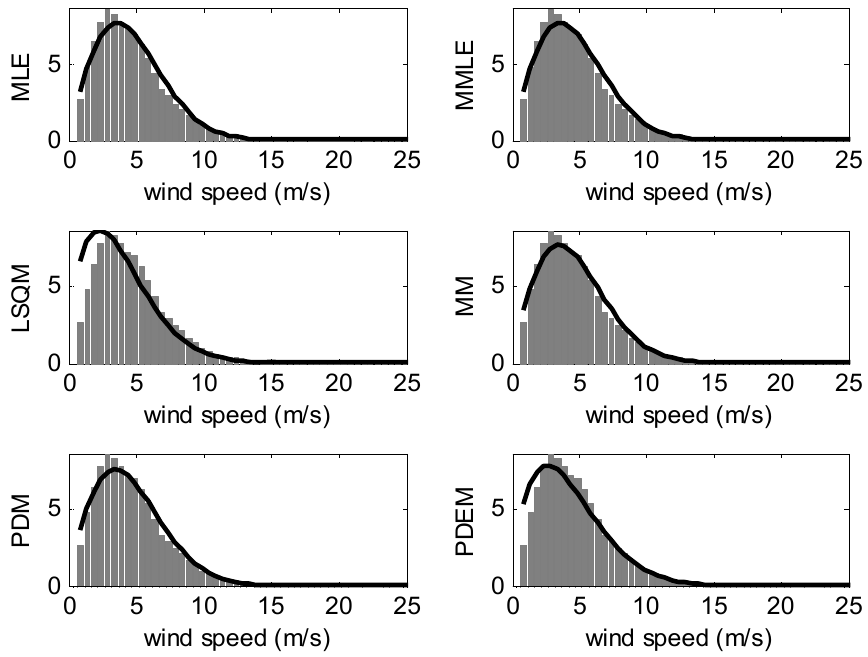
Figure 7. Histogram derived from the estimated Weibull probability density function (PDF) compared with the histogram of the wind speed data (bar diagram) at wind site n° 21 (O Cebreiro). MLE: maximum likelihood method; MMLE: modified maximum likelihood estimation; LSQM: least square method; MM: moment method; PDM: power density method; and PDEM: part density energy method.